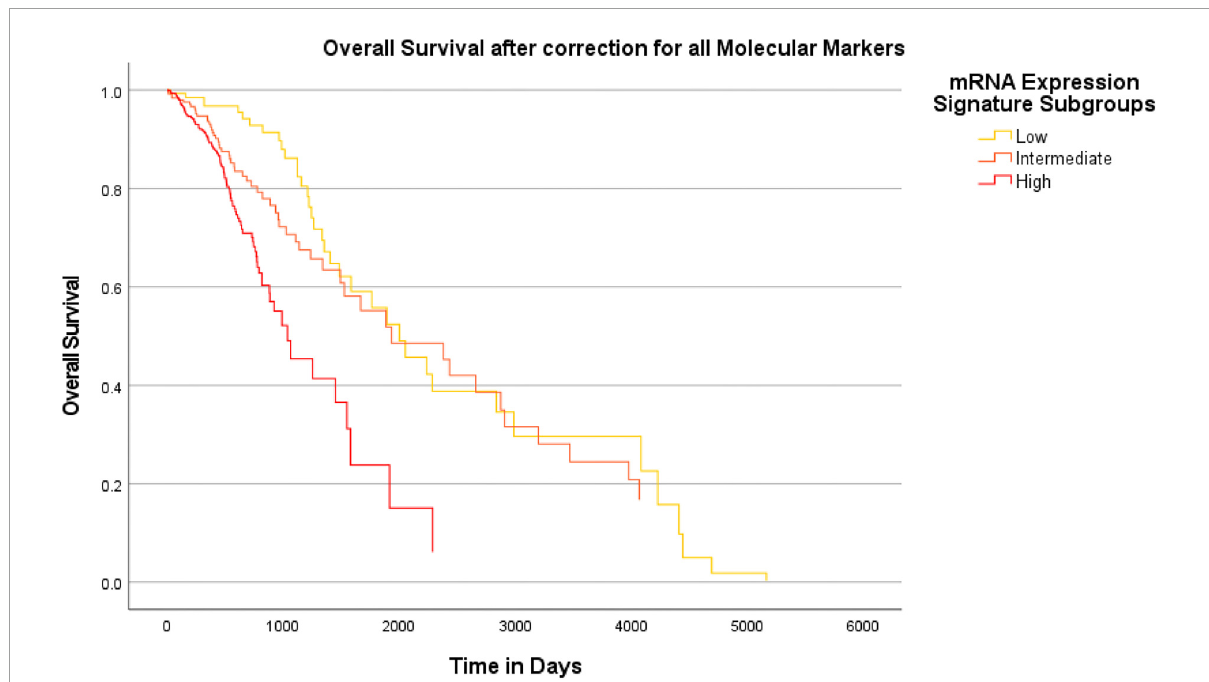
FIGURE7 Survival-curves for overall survival after correction for all molecular markers in a combined model. Kaplan-Meier curves for overall patient survival are shown after correction for all molecular markers investigated in this study within a combined Cox regression model. The heme biosynthesis mRNA expression signature showed a statistically significant ( p < 0.0005) correlation with patient survival even after combined correction for all molecular glioma